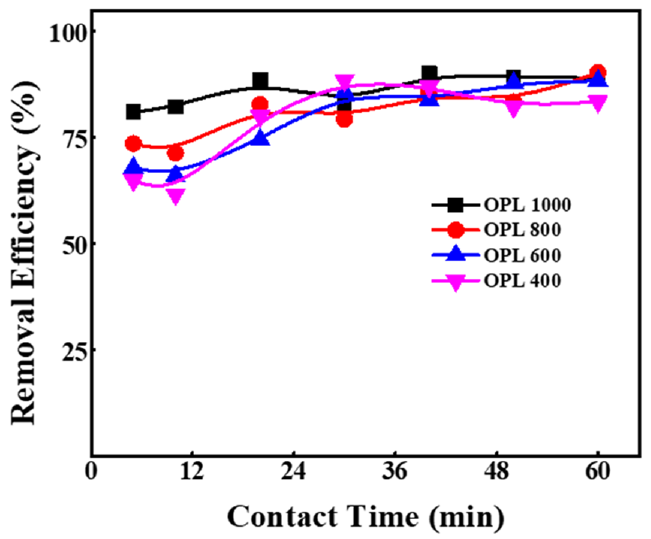
Figure 3. Effect of carbonization temperature of OPL-derived CNSs on removal of MG dye from an aqueous system.